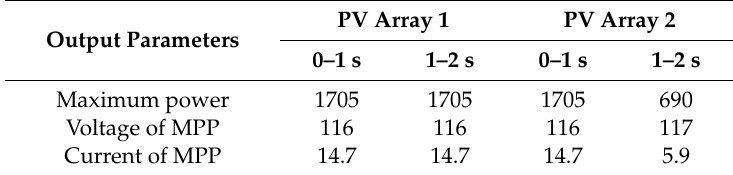
Table 3. The output parameters of the PV arrays at the maximum power point under condition